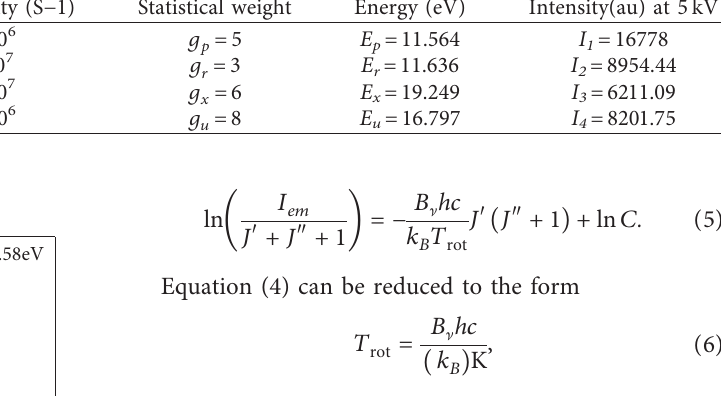
Figure 5: Spectra of the discharge at frequency 19.56kHz and an applied voltage of 5kV in argon environment (flow rate � 5L/min). Table 1: Intensity and wavelength of Ar I and Ar II lines at 5 kV. Lines